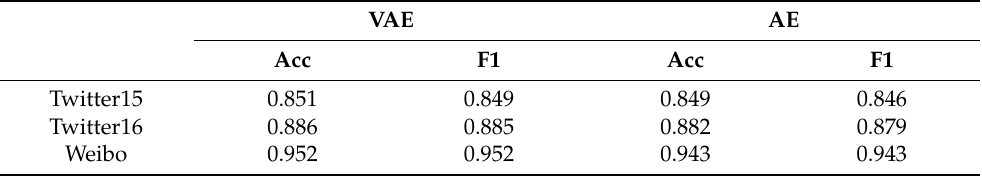
Table 5. Variational auto-encoders compared with ordinary